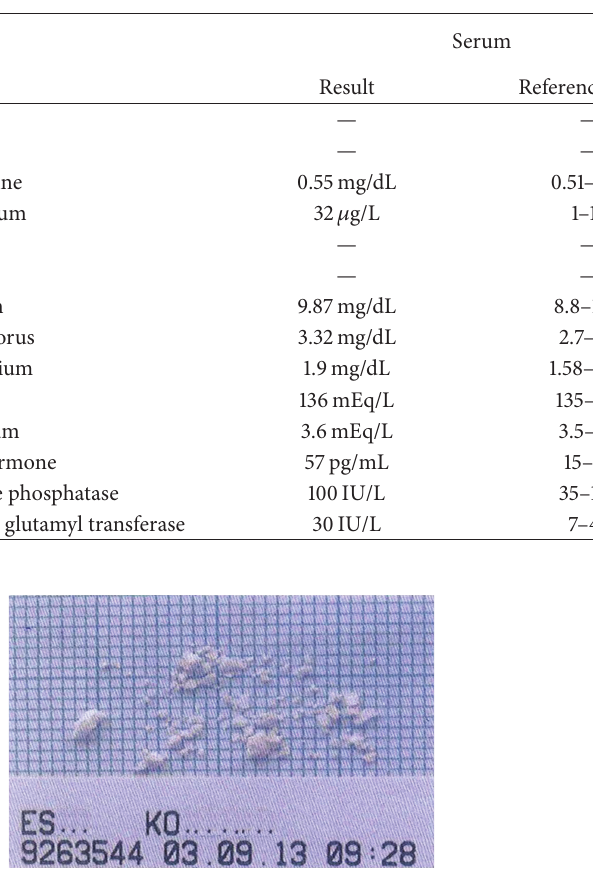
Table 1: Metabolic investigations in serum and 24-hour urinary excretion.